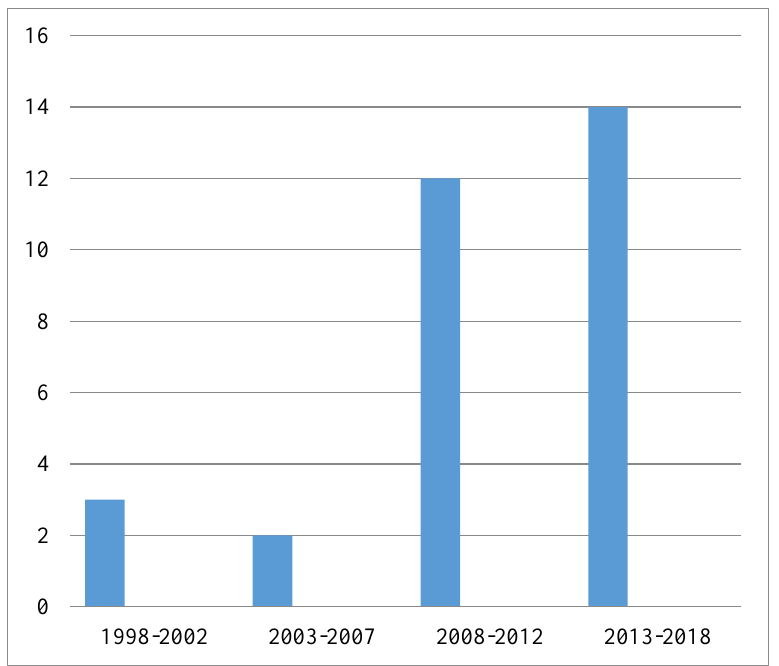
Figure 5. Percentage of Agreement among authors about the Definition of MCPs. “Source: Authors”